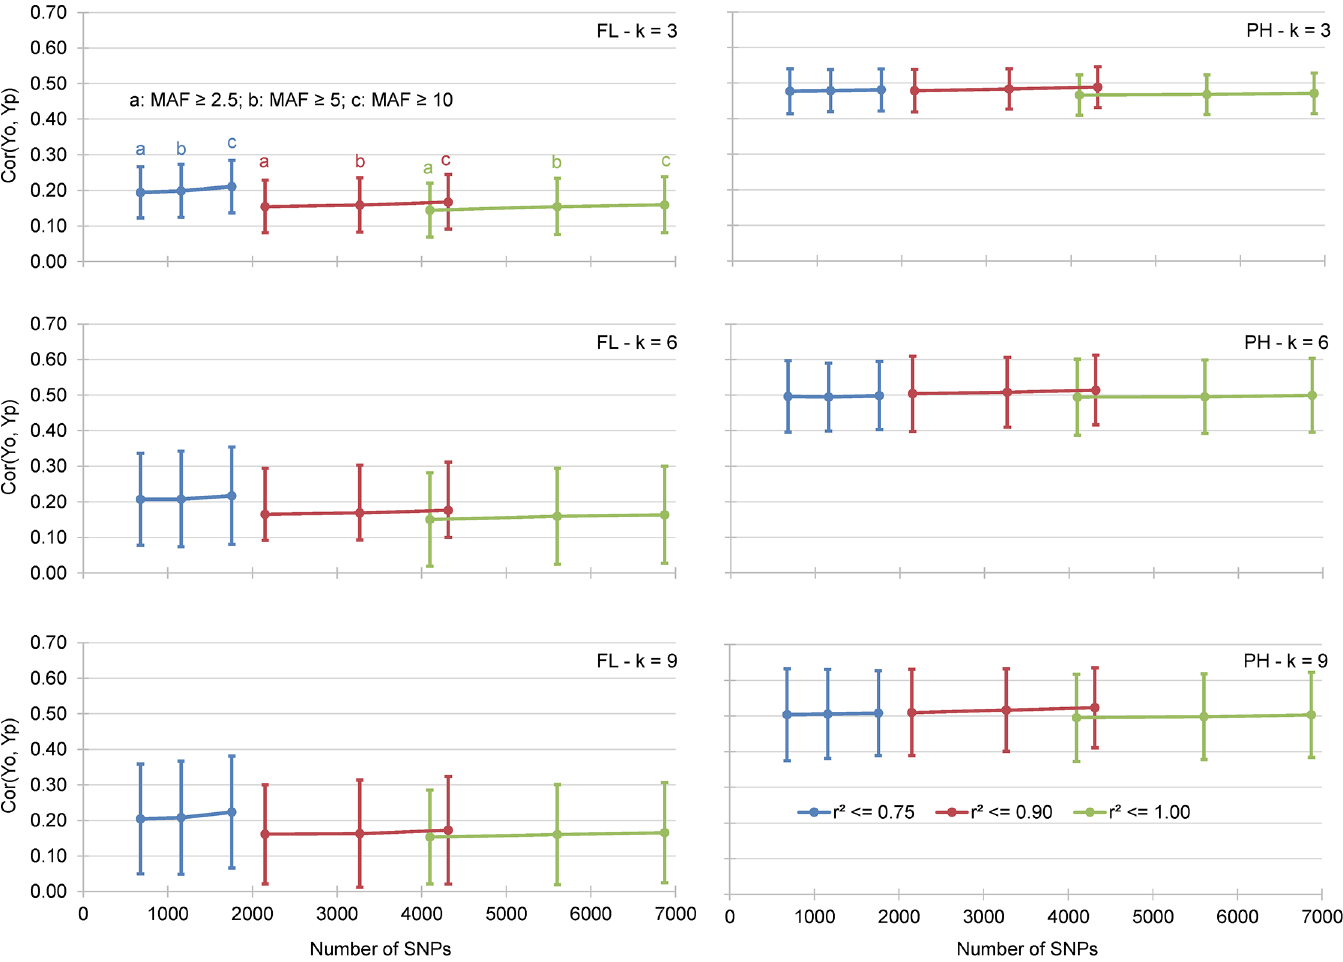
Fig 2. Mean correlation between GEBV obtained by cross validation of the training data set (Yp) and the observed BLUP values of the validation data sets (Yo). Results presented for 2 traits, 9 incidence matrices and 3 k-fold cross validation experiments.